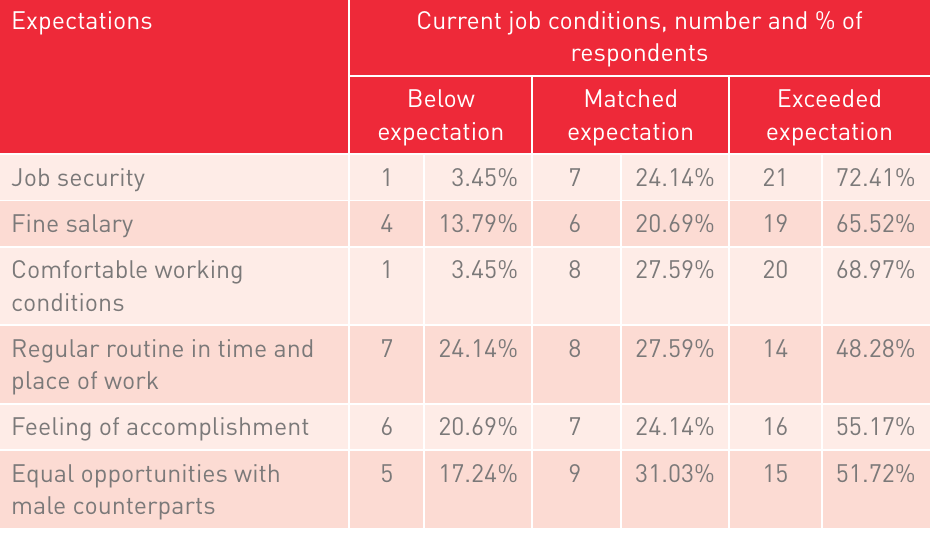
The frequency distribution of the respondents’ career expectation gaps